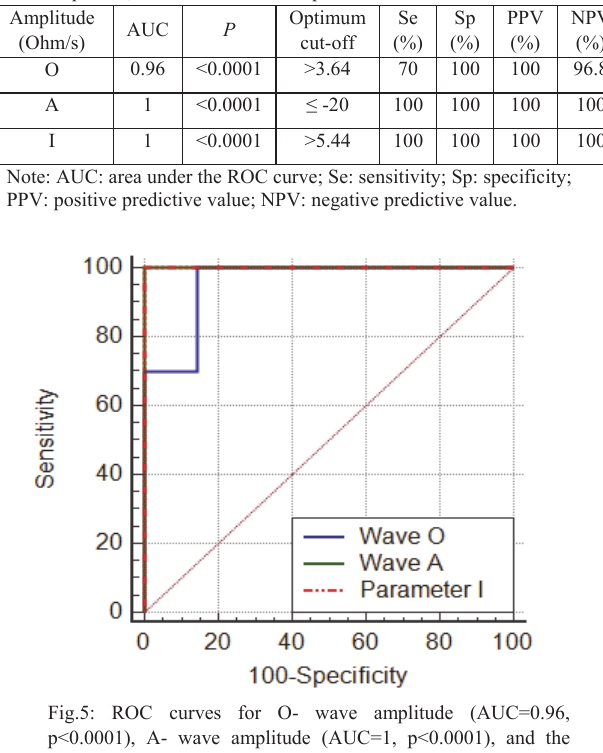
Table 4. The computed hemodynamic parameters for control subjects and patients with mitral insufficiency (mean Patients ICG waves Control subjects t–values with MI